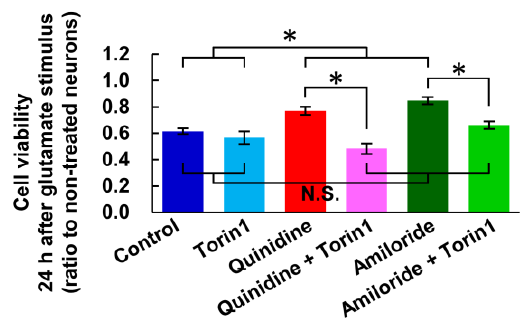
Figure 6. Inhibitor of mTOR abolished the attenuation of excitotoxicity by inhibiting Mg 2+ extrusion . Comparison of cell viability 24 h after ten-minute glutamate stimulus with or without inhibitor of mTOR (Torin1: 2.5 μM) and/or inhibitors of Mg 2+ extrusion (Quinidine: 200 μM, Amiloride: 500 μM) ( n = 12, 9, 12, 12, 12, 12 for each). Error bars indicate SEM. * indicates P < 0.05 among all possible combinations by Tukey’s test. N.S. indicates no statistically significant difference.